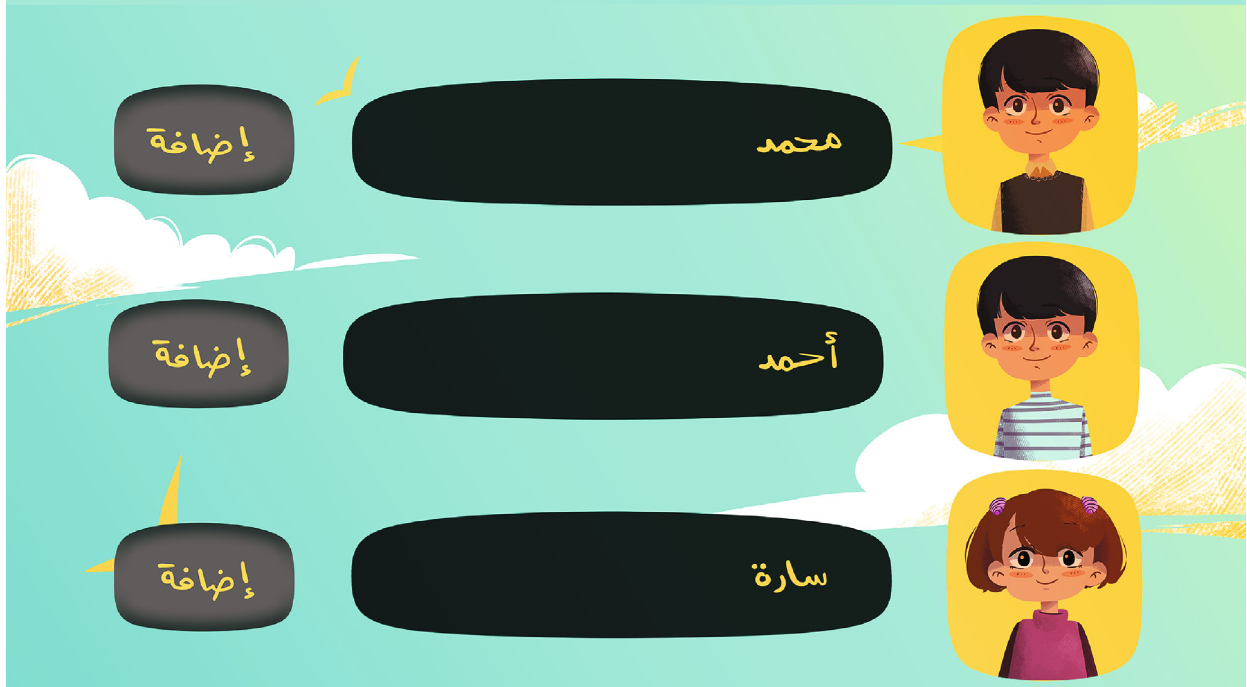
Figure 11: Friends ’ list screen.